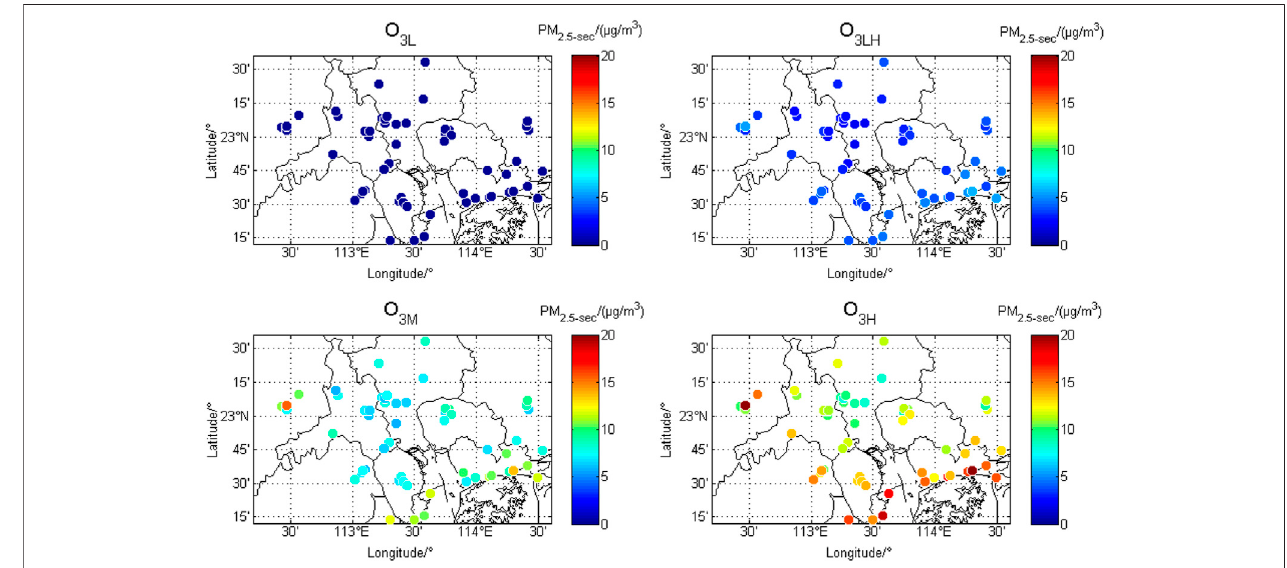
FIGURE 9 | PM 2.5-sec variations under different photochemical backgrounds.